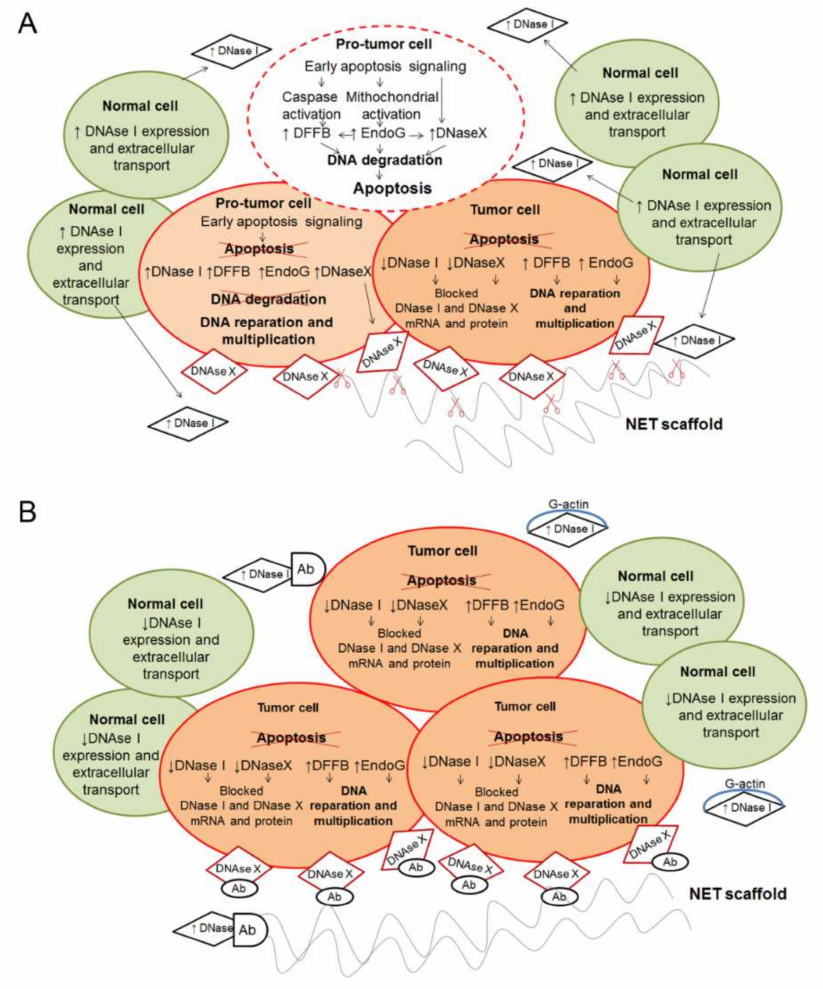
Figure 2. Changes in the activity of DNases in the early ( A ) and late ( B ) stages of tumorigenesis. ( A ) A cell with a pro-tumor phenotype accumulates changes that trigger apoptosis, including activation of EndoG, DFFB and DNase X synthesis. EndoG activates other DNases. In the case of a successful start of the apoptotic cascade, intracellular DNases and later DNase I participate in apoptosis by destroying damaged DNA. At the same time, cells of the tumor environment produce and secrete DNase I into the intercellular space, which should also promote apoptosis. If apoptosis fails, pro- tumor cells accumulate DNases, which are either present in an inactive state in the cytoplasm or are accumulated on the surface of the cell (predominantly DNase X). Surface nucleases protect tumor cells from exogenous DNA and DNA from NETs, thereby preventing the catch and destruction of tumor cells during the early stages of tumorigenesis. EndoG and DFFB take part in the processes of DNA repair and amplification, and mostly remain highly active. The total effect leads to an increase in DNase activity in tumor cells and in the tumor microenvironment. ( B ) During cell transformation, the EndoG and DFFB levels in tumor cells remain high and promote tumor growth. Tumor cells accumulate inactivated copies of DNase I and DNase X on its surface and in intercellular space. DNase I is inactivated by binding with actin filaments (mostly G-actin) and anti-DNase antibodies. Neighboring cells also reduce DNase I production. Overall, these changes lead to a decrease in DNase activity in the tumor microenvironment that reduces the apoptotic pressure on tumor cells. In addition, a low level of DNase activity leads to the accumulation of NETs; the development of inflammation; an increase in the functioning of transformation cascades in the tumor cell; as well as their detachment, migration and